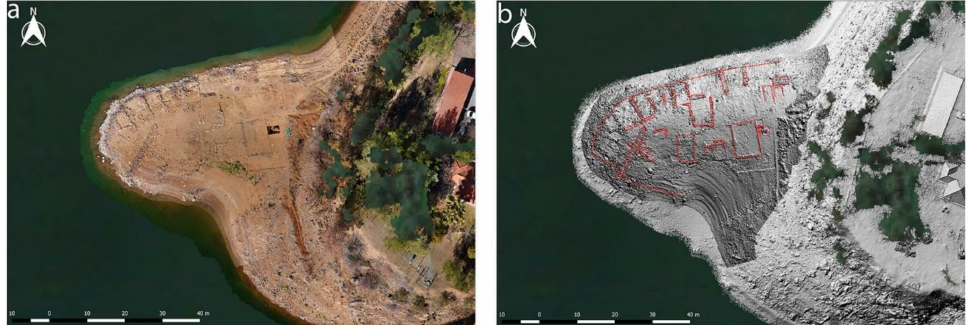
Figure 7. Archeological site documented through remote sensing acquisitions. ( a ) Aerial overview.